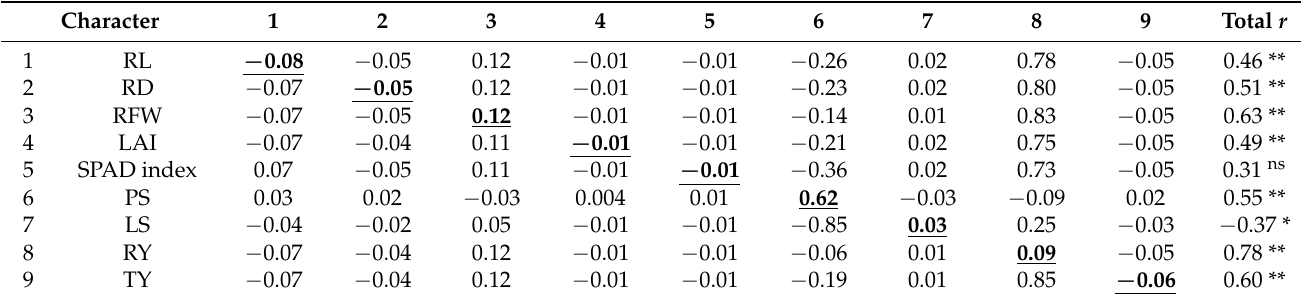
Table 11. Direct (underlined diagonals) and indirect effects of pure sugar yield (PSY) components and their correlations with PSY under saline soil (EC e = 8.60 dS m − 1 ) conditions (data pooled over both